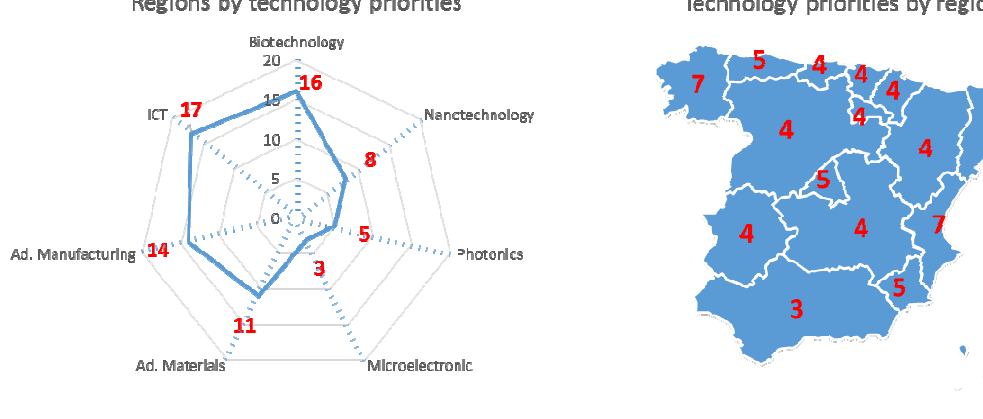
Figure 1: Regions in Spain by Type of Technological Priority Included in